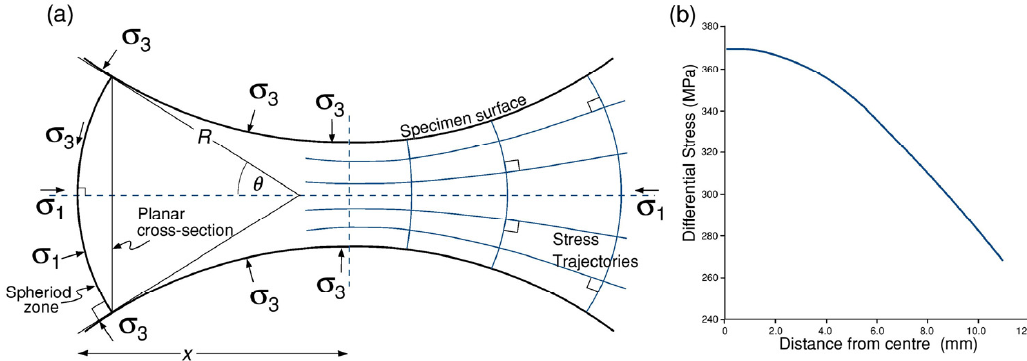
Figure 3. ( a ) Differential stress versus axial strain for the central 20 mm of the length of the specimen, where most of the ductile strain is accumulated. With respect to the overall specimen length the total strain at the end of the test is 0.9%. The stress/strain curve is compared with that of Carrara marble specimen CM22 of Rybacki et al. [8], which was deformed under similar conditions; ( b ) The distribution of permanent axial strain along the length of the specimen from post ‐ test measurements of change in radial dimensions of the specimen, assuming deformation at constant volume. The principal stresses along the axis of the specimen are expected to be parallel and perpendicular to the specimen axis, whereas at the periphery of the sample, where the confining pressure acts normal to the free surface, they are expected to be parallel and perpendicular to that surface. Thus the stress trajectory pattern will be curved, as illustrated in Figure 4a, and the ( σ 2 = σ 3 ) surfaces will form a series of spherical caps. At all cross- sections through the specimen the axial force will be the same, thus the stress across all such spheroidal segments will be the force/cap area. The force in the middle of the specimen is the final stress (372 MPa) × the local area (210.3 mm 2 ) = 78.2 kN. Differential stresses reported are estimated to be accurate to ± 1.5 MPa.